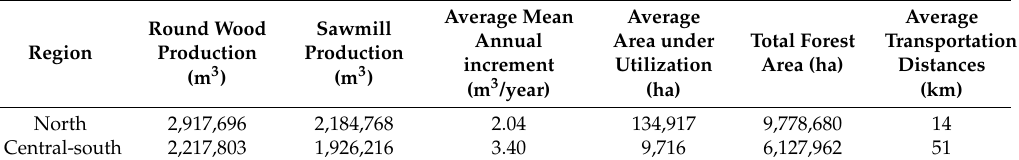
Table 10. Differences in forestry parameters according to